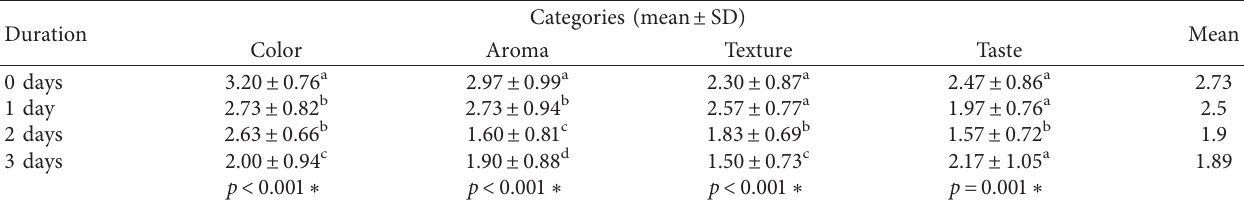
Table 6: Results of the organoleptic analysis of fermented shrimp sausages at different fermentation